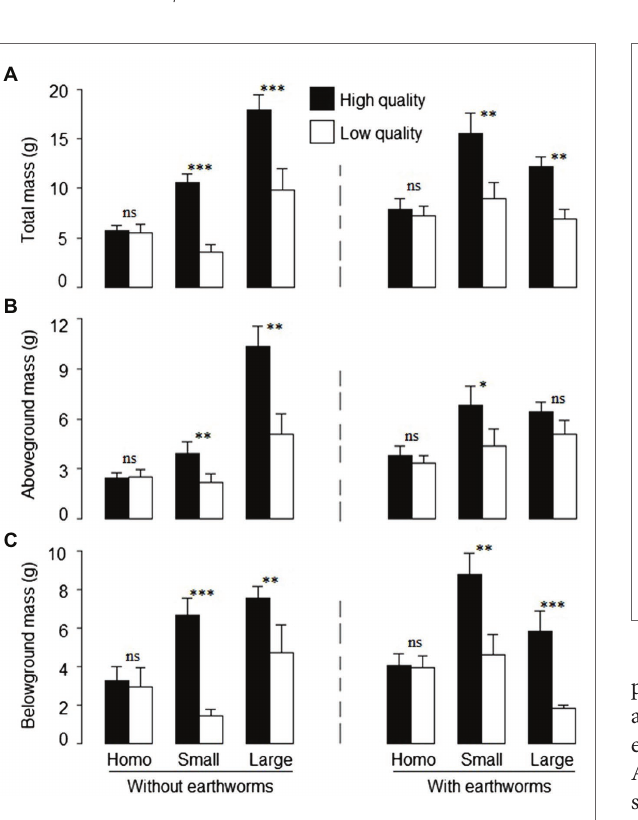
FIGURE 3 | (A) Total, (B) aboveground, and (C) belowground mass of offspring ramets of Leymus chinensis in the high- and low-quality patches in the heterogeneous small patch and large patch treatments and in the imagined high- and low-quality patches in the homogeneous treatments with or without earthworms. Mean ± SE ( n = 6) are given. Symbols above pairs of bars shows significance levels (*** p < 0.001, ** p < 0.01, *p < 0.05 and ns p > 0.05; by linear contrast).